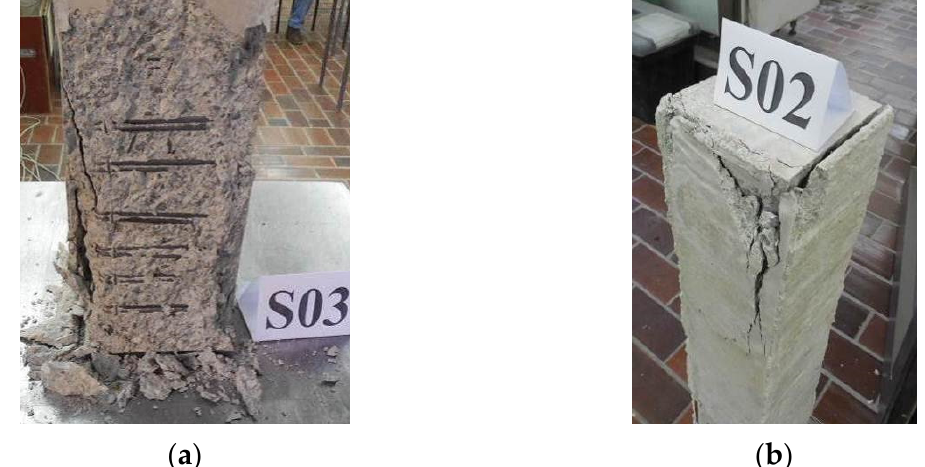
Figure 6. Failure modes of plain RC columns. The bottom part of specimen S03 ( a ), and the top part of specimen S02 ( b ).